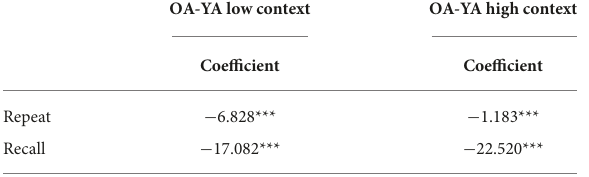
TABLE 5 Interaction effects of age groups * Context in Repeat and